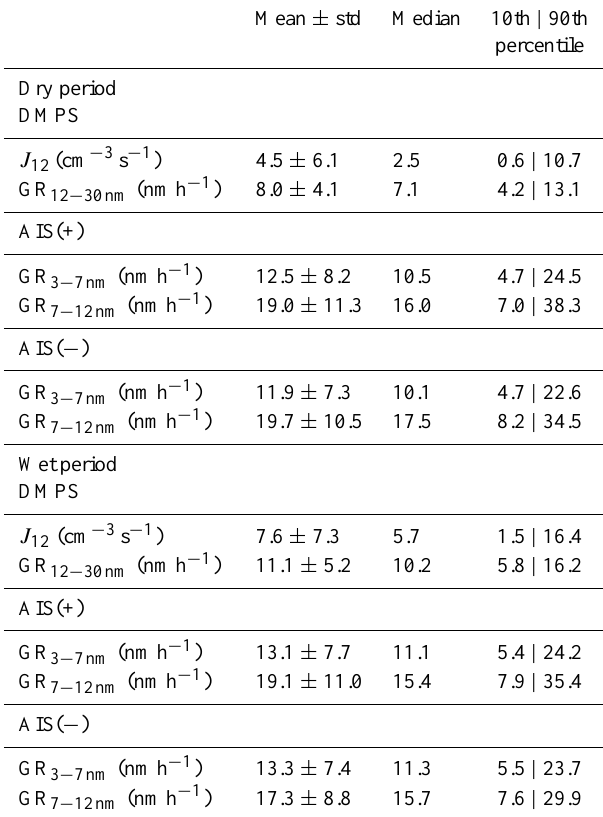
Table 4. Mean, median, standard deviation, and 10th/90th per- centiles of growth rate (GR) and formation rate ( J 12 ) separately for dry and wet periods based on the DMPS. The growth rates based on the AIS data were calculated separately for the positive and the negative